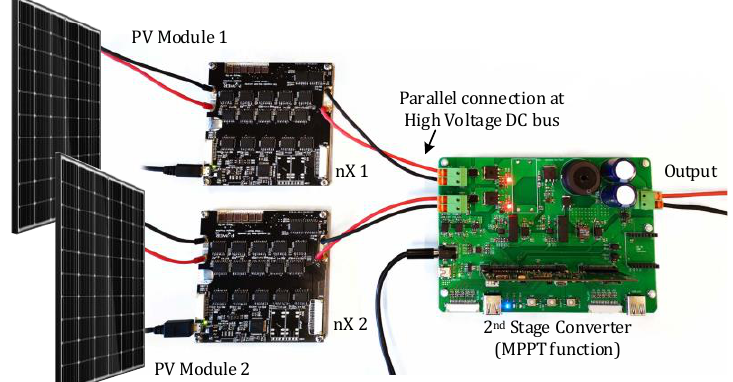
Figure 9. Experimental setup consisting of two VMPV modules.